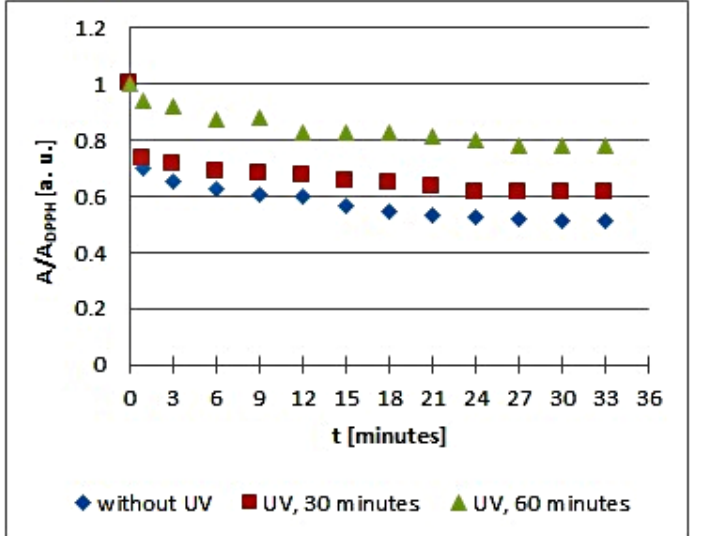
Figure 6. Changes of the relative amplitude (A/A DPPH ) of EPR spectra of DPPH free radicals with increasing time of interactions ( t ) with infusions of Mitchella repens herb. A—amplitude of the EPR line of DPPH free radicals in contact with the tested samples. A DPPH —amplitude of the EPR line of DPPH free radicals in the reference solution. For the reference solution, the relative amplitude (A/A DPPH ) takes a value of 1. Data for the infusions obtained from the plant materials exposed to UVA radiation for 30 and 60 min are presented. For comparison, data for the infusions of the plant material that was not exposed to UVA radiation are also given.